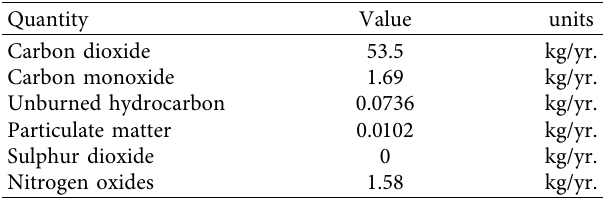
Table 7: Properties data of the system under study for Scenario 2.